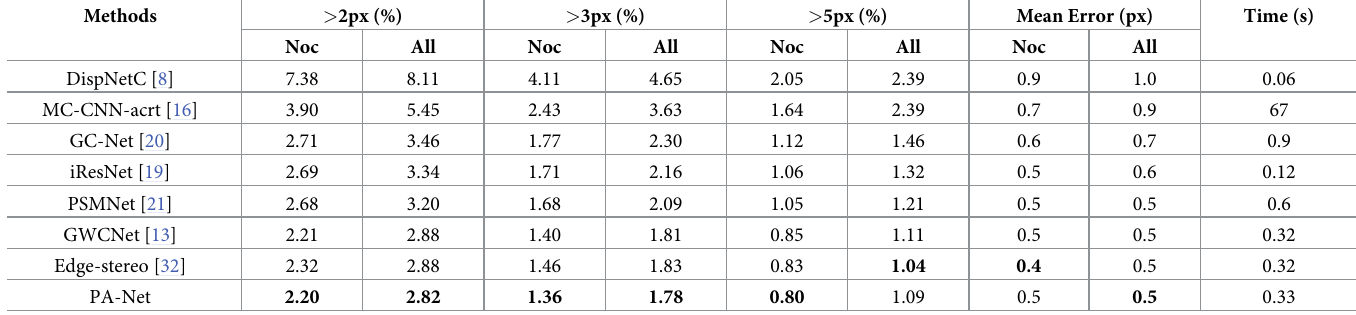
Table 2. Performance comparison of KITTI 2012 [9] test set. The GWC-Net [13] and PSM-Net [21] are trained with the same batch size as our method for fair comparison.